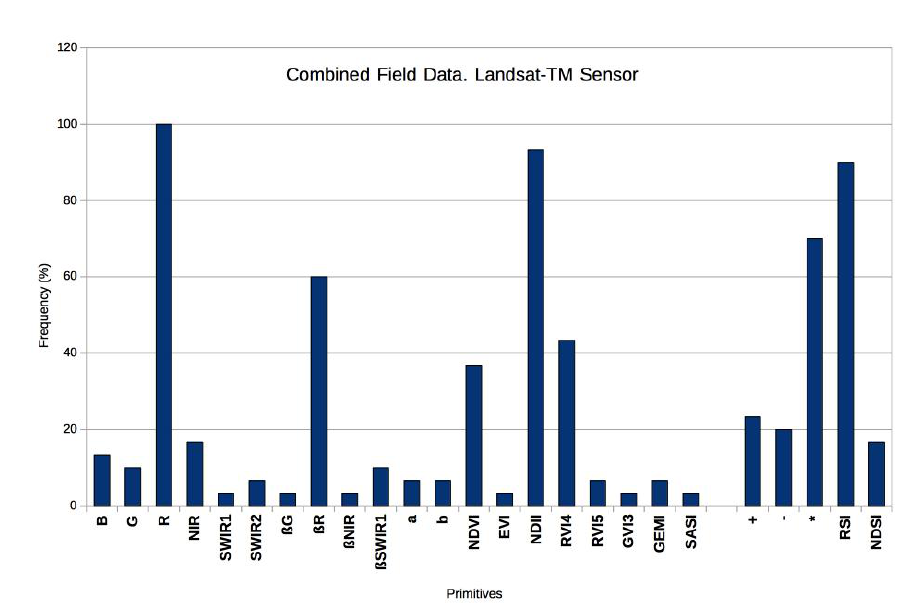
Figure 8. Frequency Of Use (FOU) for the elements that form the primitive set for the combined field data for both watersheds using the LandSat-TM sensor. The maximum possible value is